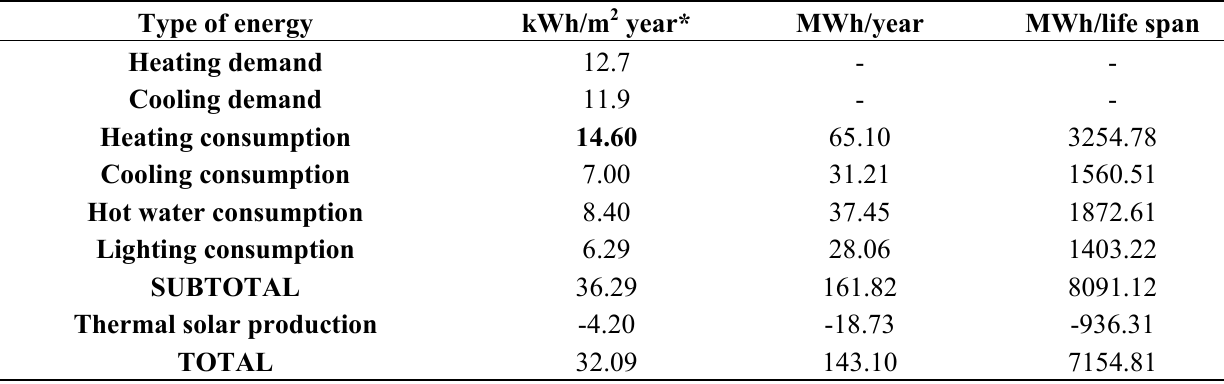
Table 5. Energy demand for heating and cooling and final energy consumption of the building ( * the ratios are expressed in useful, air conditioned m 2 ).